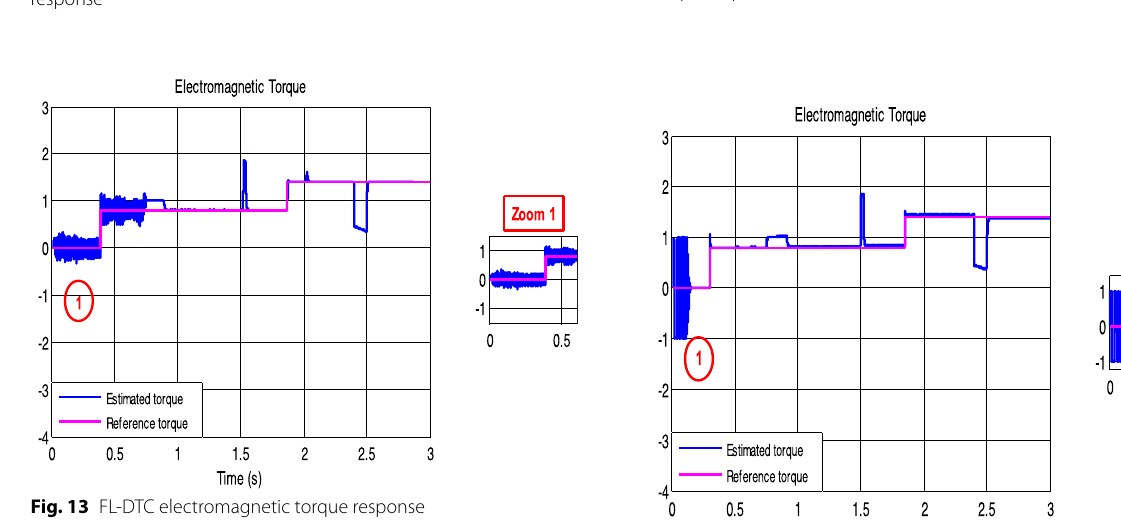
Fig. 14 PI-DTC-SPWM with three-level inverter electromagnetic torque response